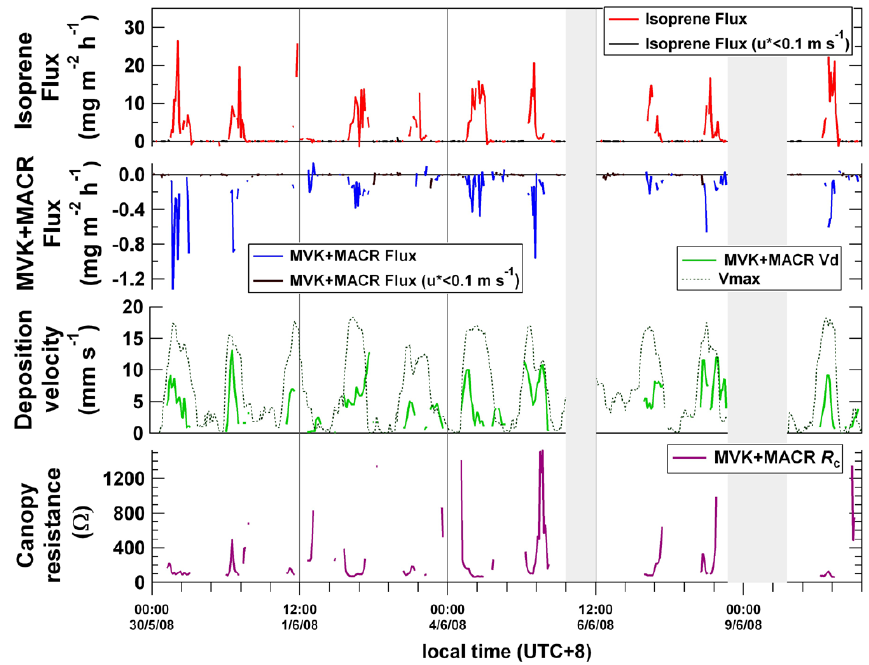
Fig. 8. MVK+MACR flux (blue), deposition velocity (green) in relation to maximum theoretical deposition velocity (V max ) and the isoprene flux (red) for